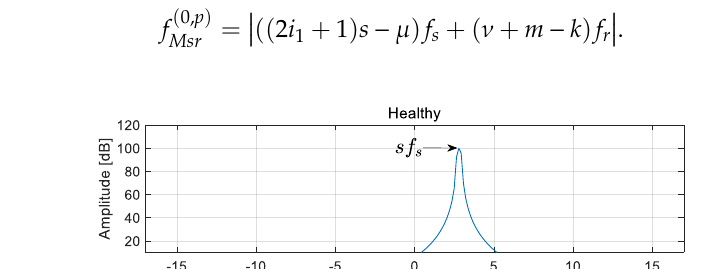
Table 2. Characteristic frequencies for particular fault types.